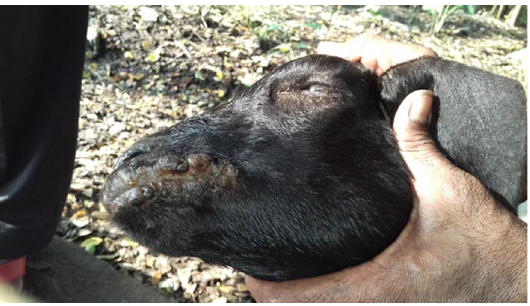
Figure 1. ORFV infection in goat. Representative figure depicting clinical cases of ORFV infection in Black Bengal goat having proliferative lesions around the lip recorded in the study